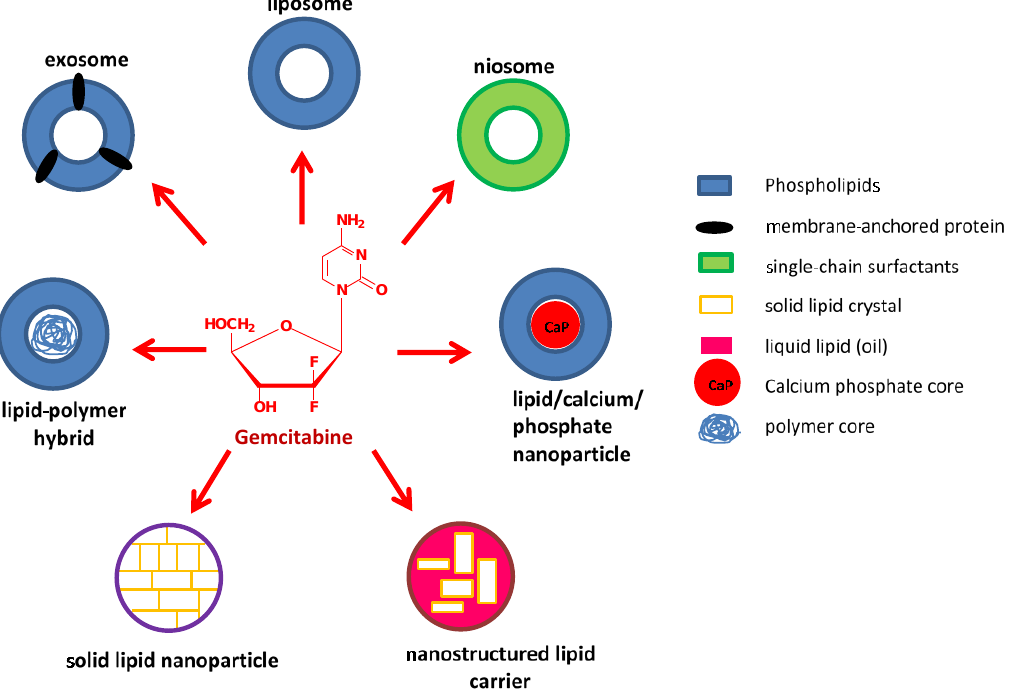
Figure 1. Illustration of some lipid-based nanocarriers being used in gemcitabine delivery.